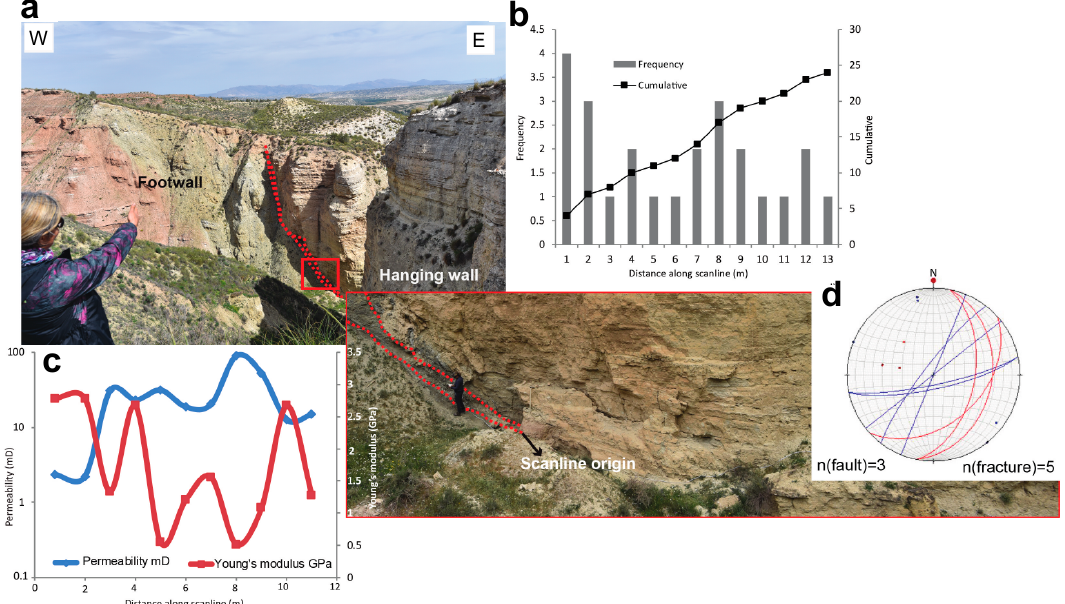
Figure 4. ( a ) A photo of the northern segment of the Baza Fault (Cañada Gallego site). Note that the scanline measurements were conducted in the hanging wall of this fault. ( b ) Frequency and cumulative distribution of fractures. ( c ) Permeability and Young’s modulus measurements along the scanline. ( d ) Stereoplot of the fault (red) and fracture (blue)